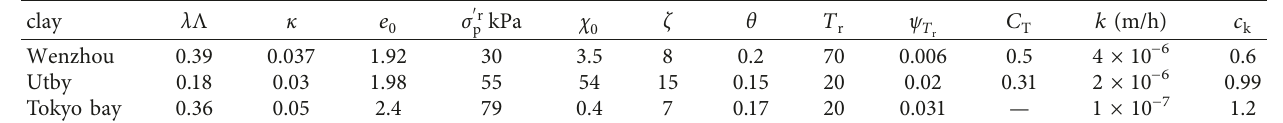
Figure 6: Bonding effect on the compressibility and the evolution of bonding ratio: (a) compression curves for intact and reconstituted Wenzhou clay at T 20 ° C; (b) illustration of the bonding elimination with viscoplastic strain; (c) evolution of bonding ratio with viscoplastic (cid:31) strain. Table 1: Values of model parameters and state variables for selected